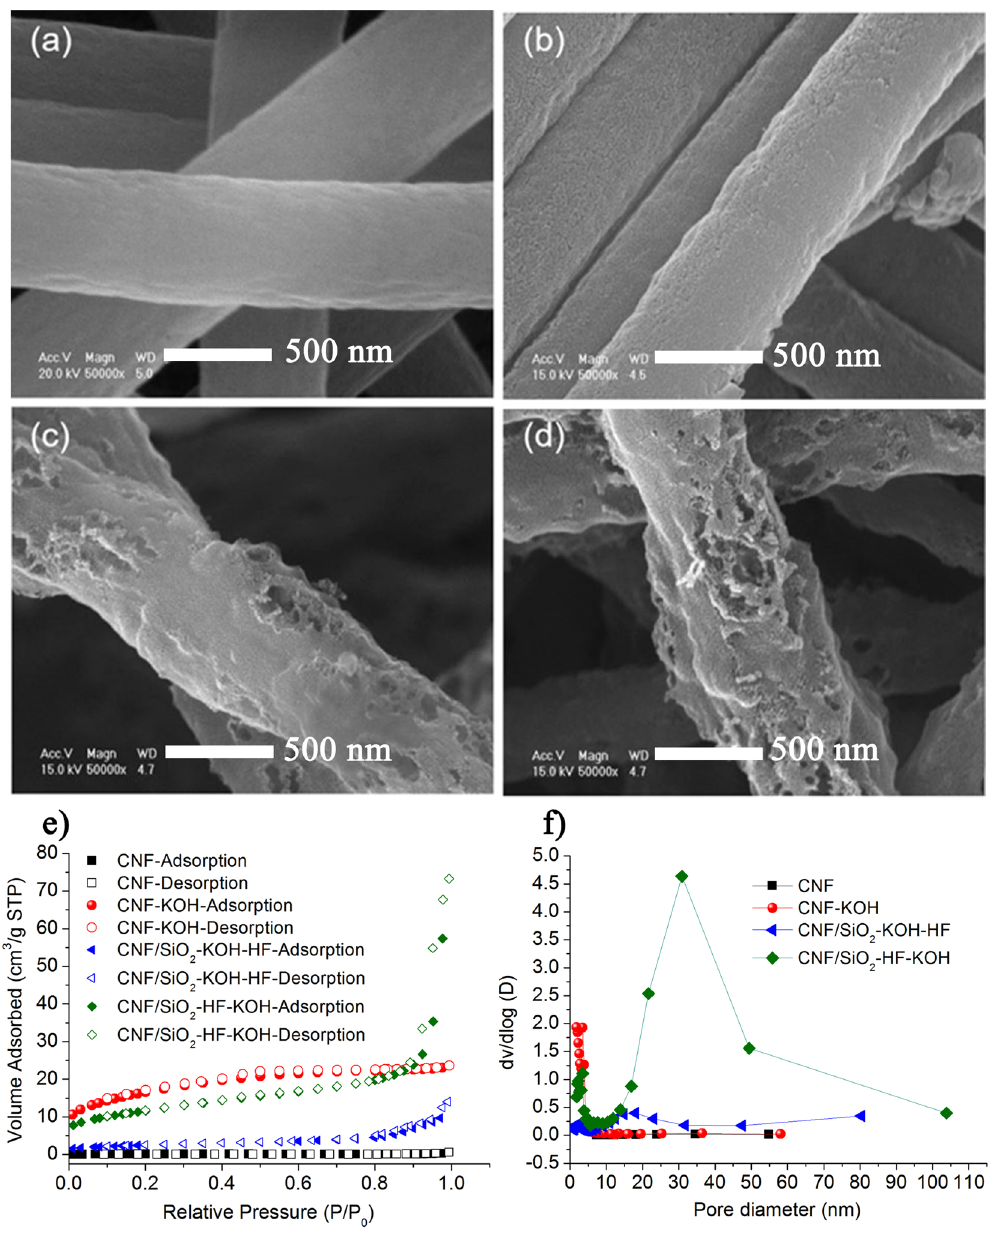
Figure 3. SEM images of the ( a ) pristine CNF, ( b ) CNF-KOH, ( c ) CNF/SiO 2 -KOH-HF and ( d ) CNF/SiO 2 - HF-KOH membranes, respectively. ( e ) BET N 2 adsorption-desorption isotherms and ( f ) pore size distribution determined from the BET